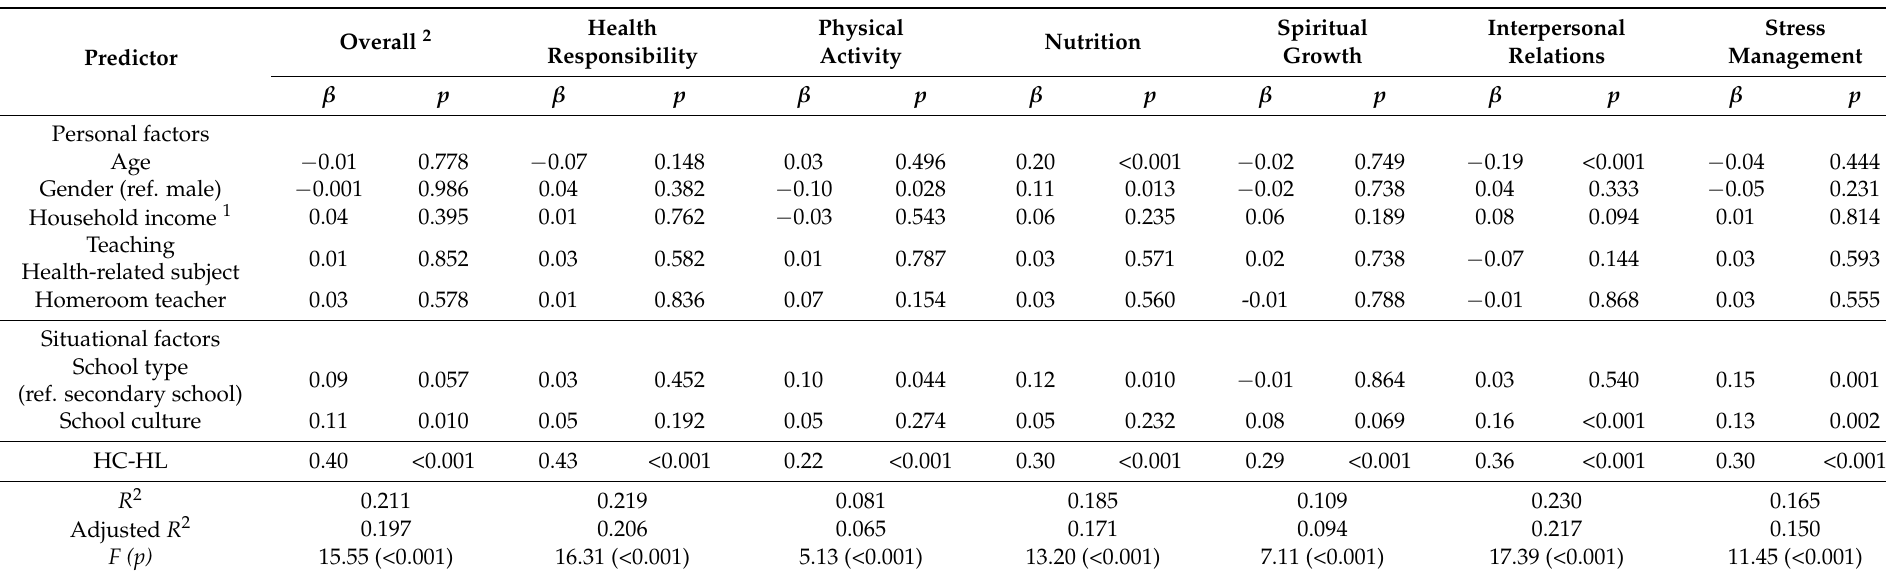
Table A1. Predictors of health-promoting behaviors among teachers by HPLP-II subdomain on the healthcare domain of health